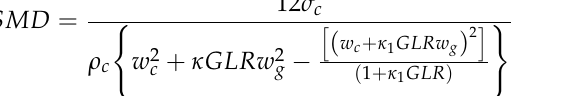
Figure 15. Diagram of the dependence of spray angle on GLR determined with a classical bubble atomizer and its modifications [118].